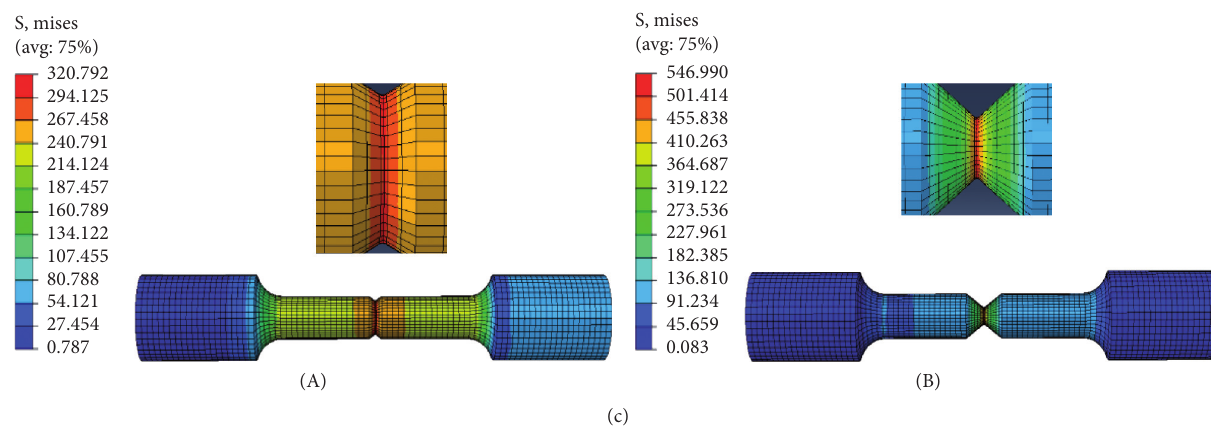
Figure 5: Mises stress figures of different notch depths. (a) Symmetric 30: notch depth of (A) 0.5mm and (B) 1.5mm. (b) Symmetric 45: notch depth of (A) 0.5mm and (B) 1.5 mm. (c) Symmetric 60: notch depth of (A) 0.5mm and (B)